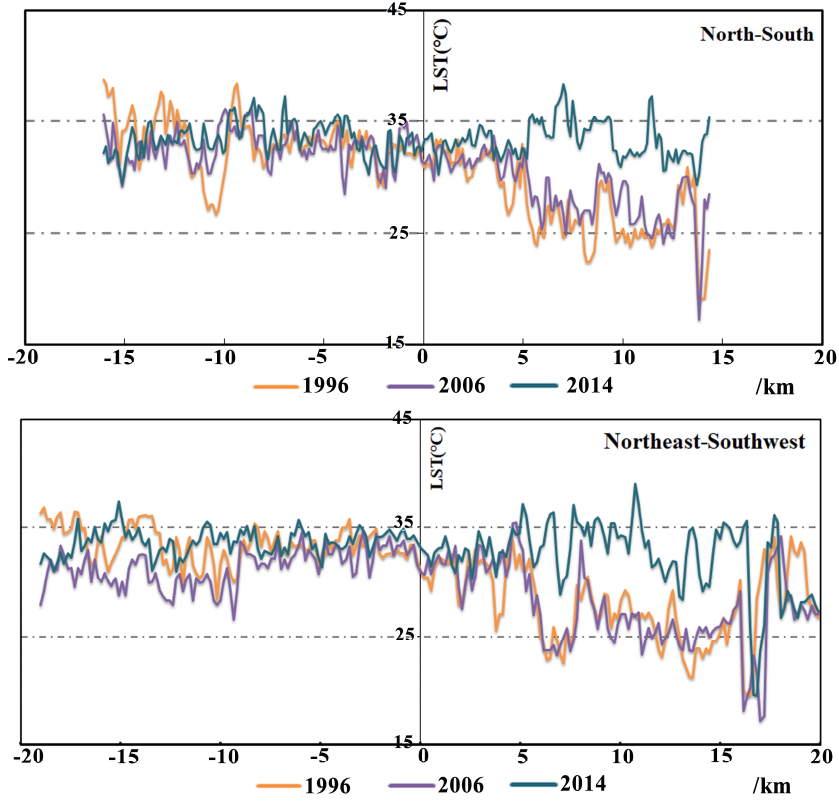
Figure 4. Cont. Figure 4.